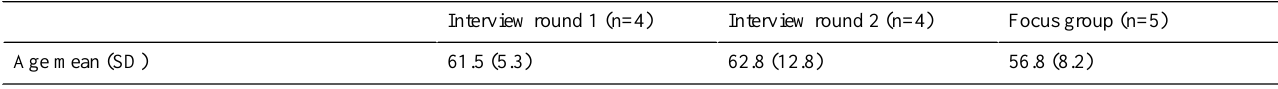
Table 3. Characteristics of respondents with DM2 from the interviews and focus groups.